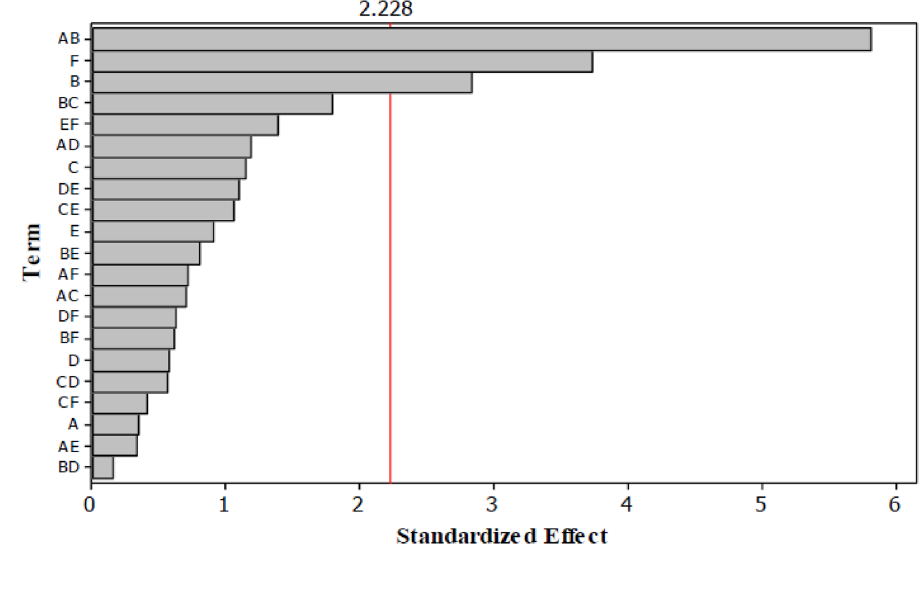
Table 6 Estimated effects and coefficients for % E of Cu(II) after adjustment